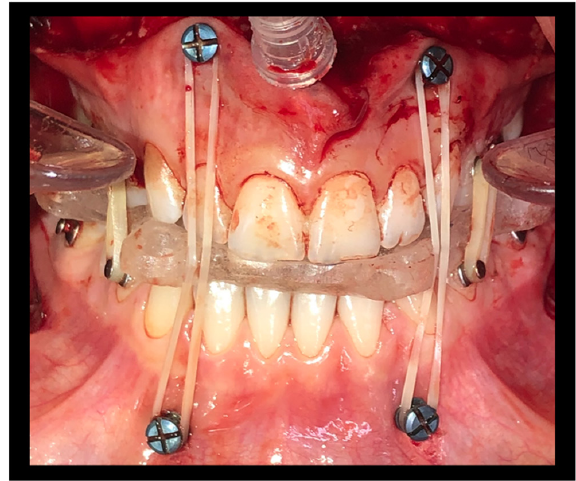
Figure 6. Intra-operative photographs showing the intermaxillary fixation with